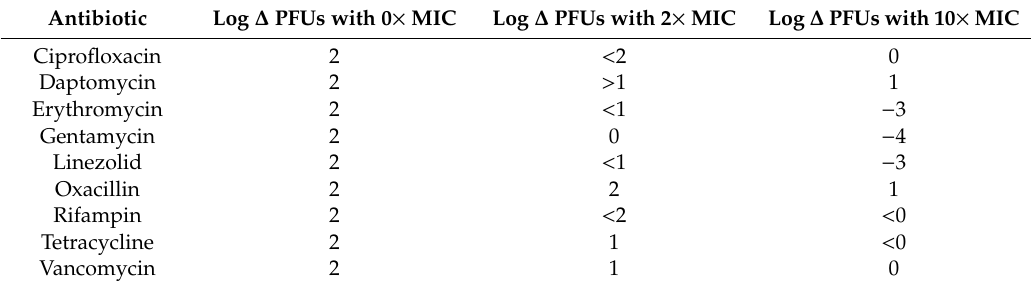
Table 3. Impact of Di ff erent Antibiotics on S. aureus Biofilm Support of Phage Virion Production 1 .